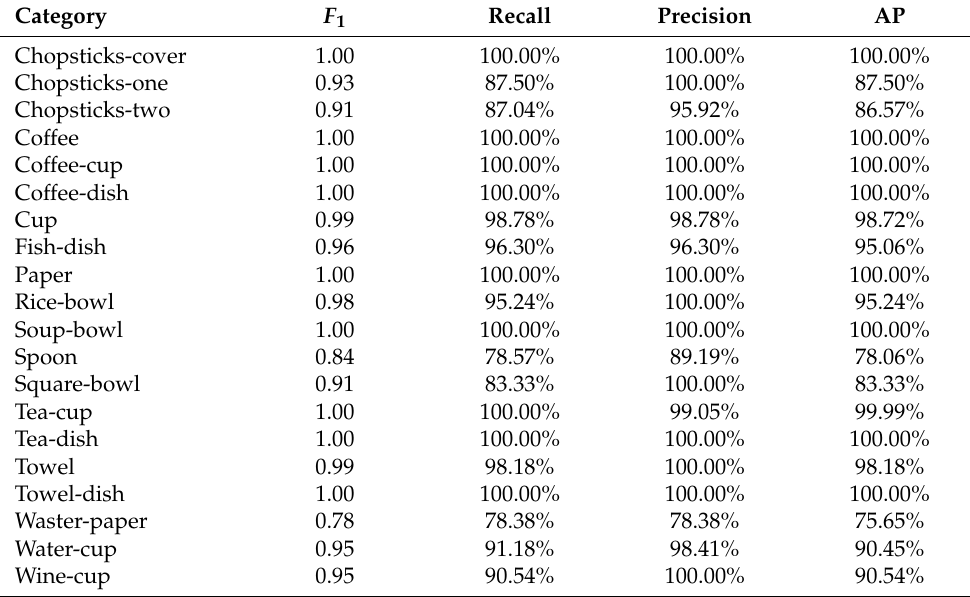
Table 1. Test results of different dish classes in YOLOv4.